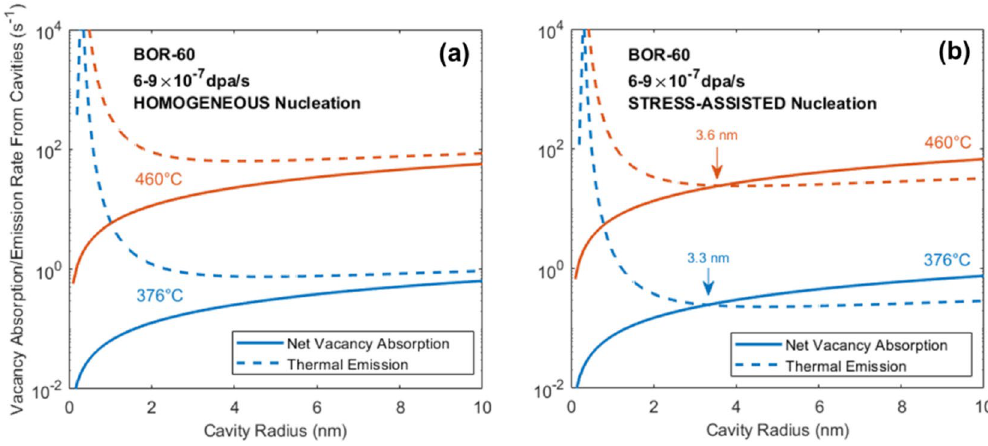
Figure 2. Comparison of the net vacancy absorption and thermal vacancy emission components of cavity growth for BOR-60 irradiation assuming ( a ) homogeneous nucleation and ( b ) the inclusion of a stress-assisted mechanism.